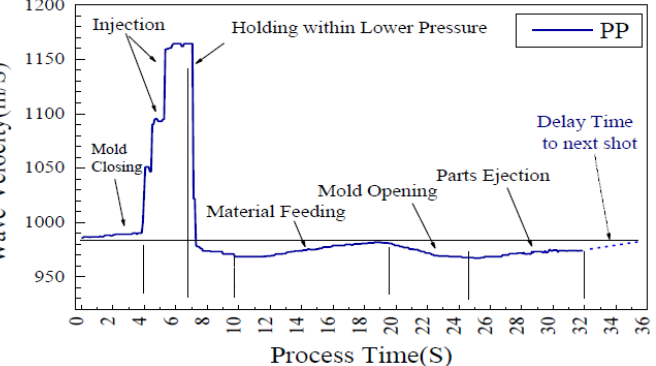
Figure 9. Velocity of ultrasonic signal at the nozzle during injection moulding process [56].